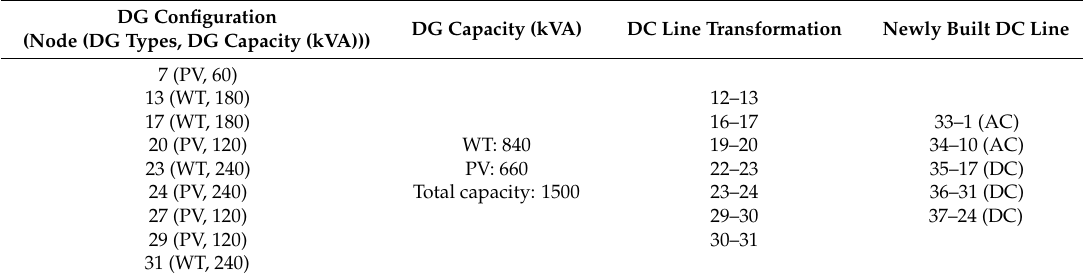
Table 3. The planning results when considering the DC line transformation and newly built DC line.